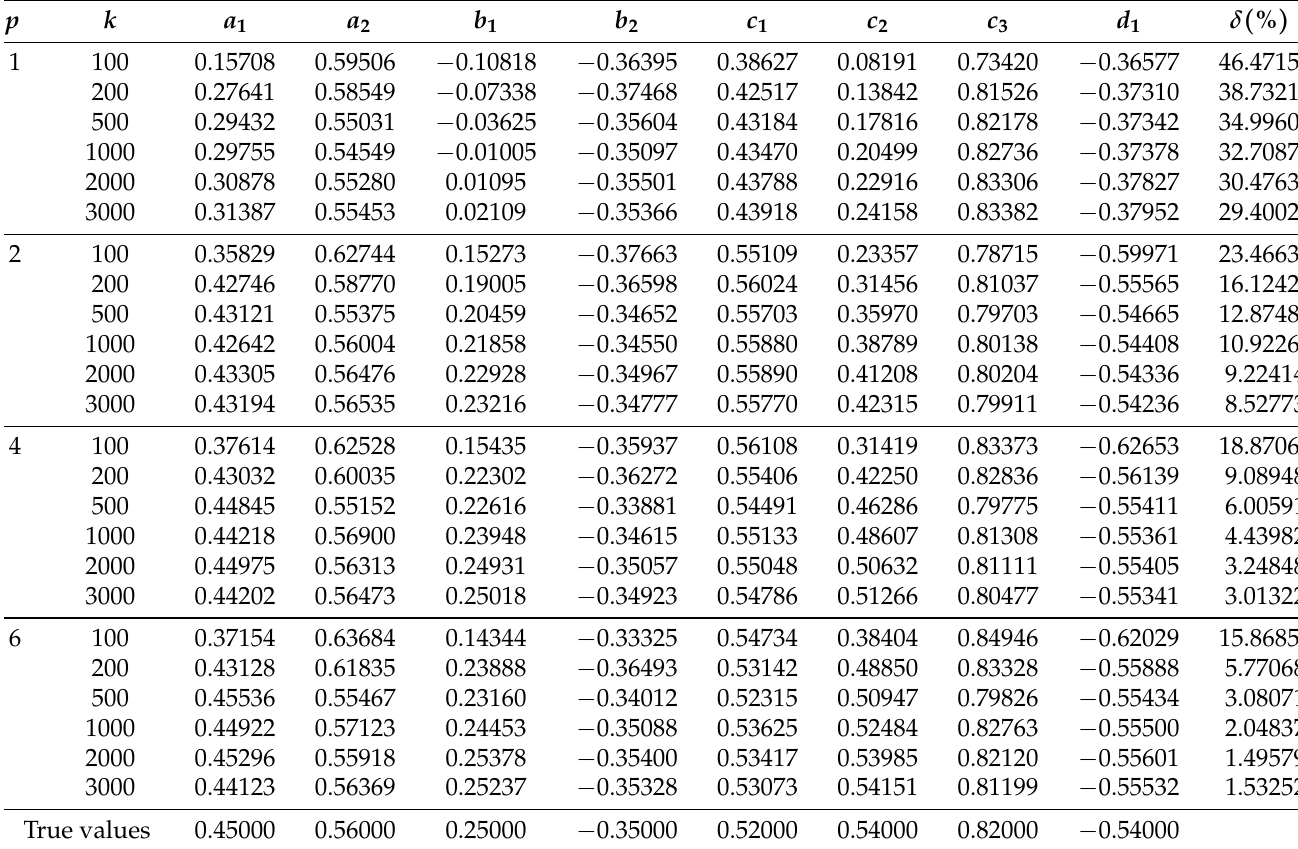
Table 2. The AM-MIFSG estimates and errors with p = 1, 2, 4 and